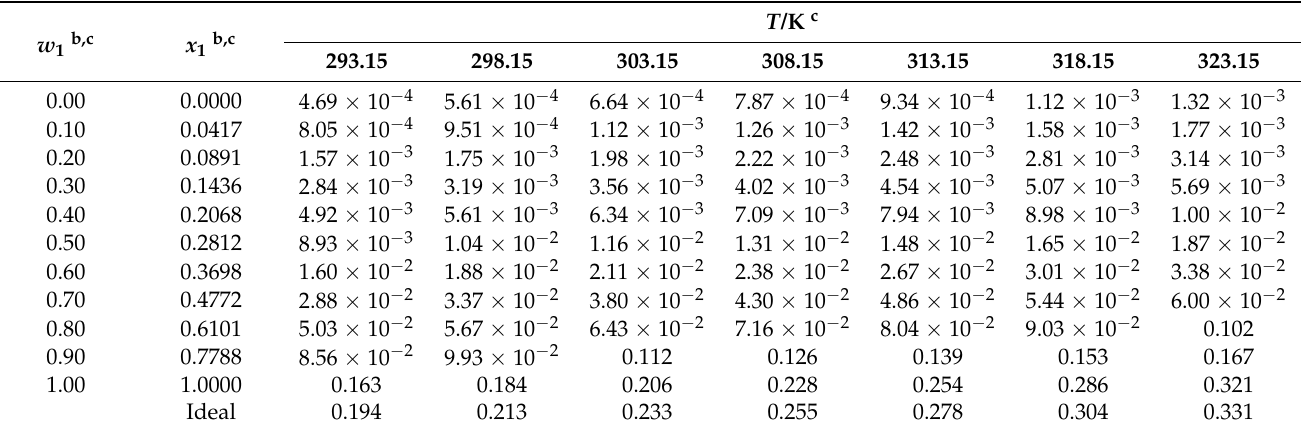
Table 2. Experimental and ideal mole fraction solubility of benzoic acid ( x 3 ) in {ethanol (1) + water (2)} mixtures at several temperatures and p = 90 kPa a,c .